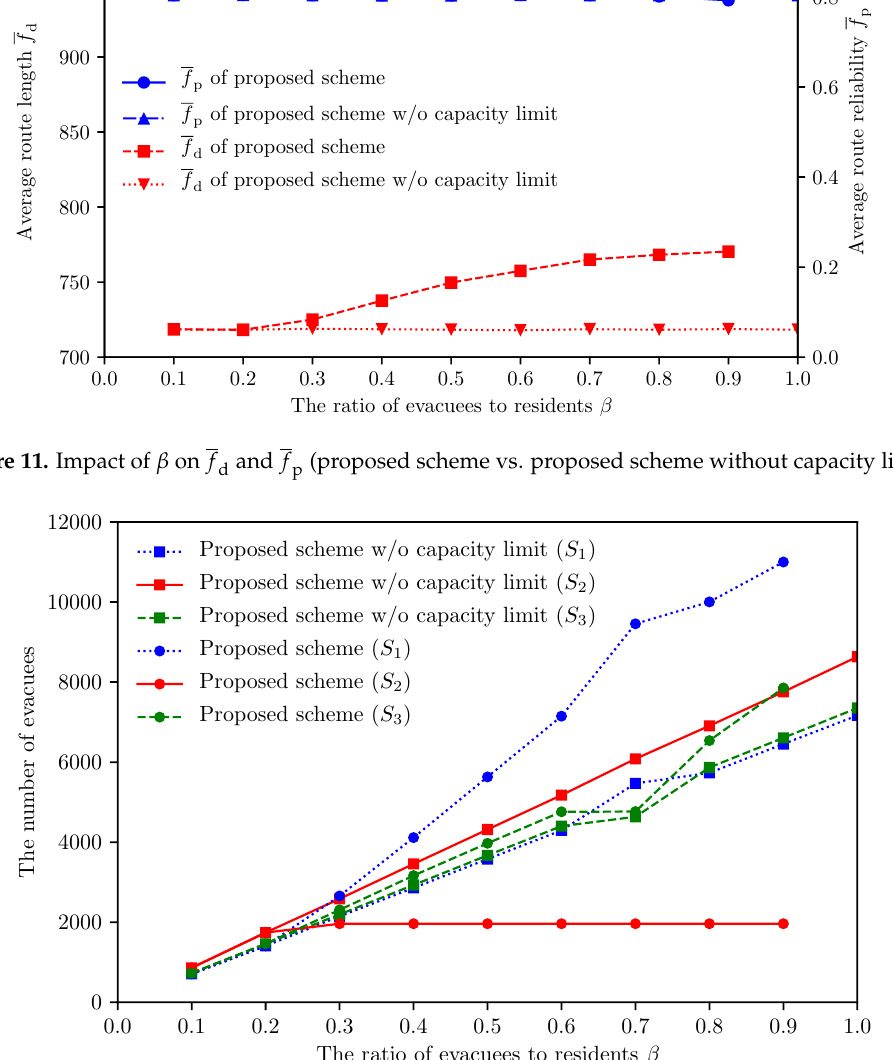
Figure 12. Impact of β on the number of allocated evacuees per refuge (proposed scheme vs. proposed scheme without capacity